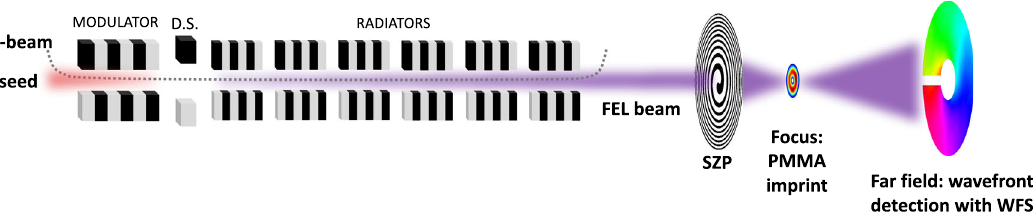
FIG. 6. Generation of intense, coherent XUV vortices at the fundamental FEL wavelength with a SZP. The fundamental, transversely Gaussian FEL beam was sent onto the SZP, producing a micron-size optical vortex in the focal plane, which was detected using the PMMA imprint method; see text for details. The spiral phase of the vortex was measured in the far field (80 cm from the focal plane) with a